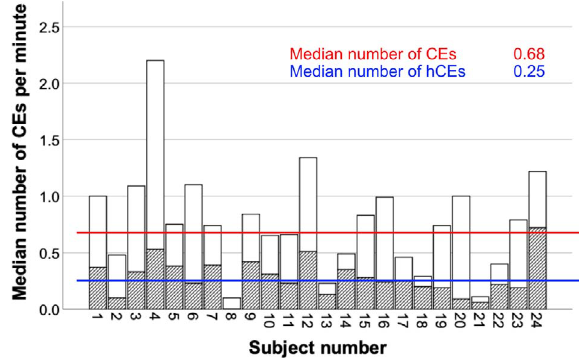
Figure 4. Median number of CEs per minute (white part of column) and proportionally the median number of hCEs per minute (hatched part of column), n = 24 subjects with four LCs each (total 96 LCs with four LCs per column)